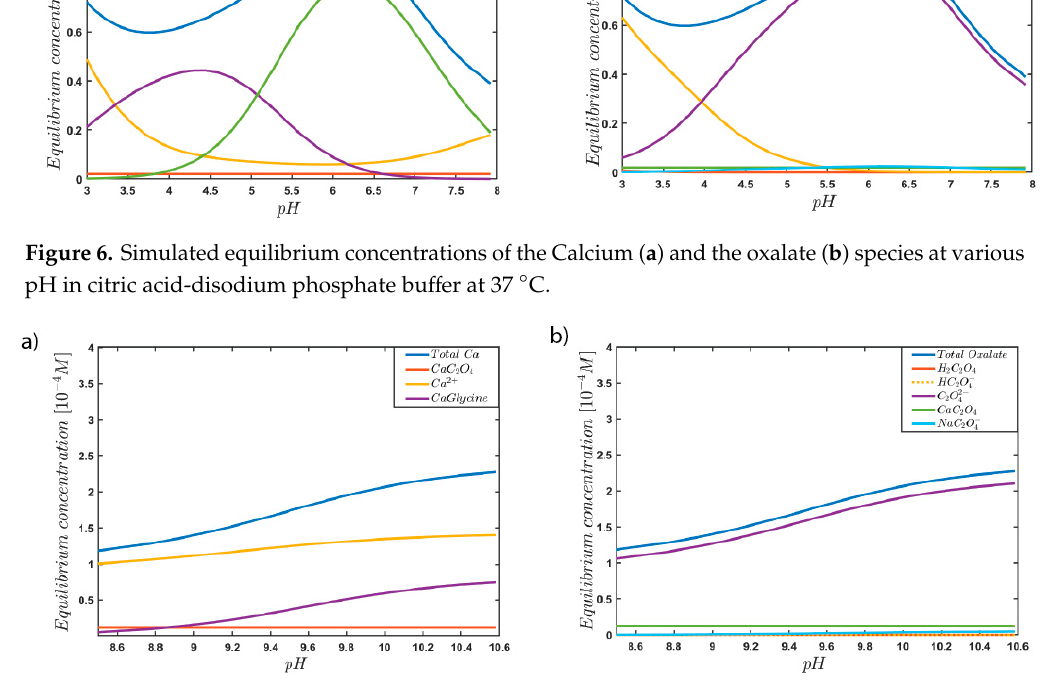
Figure 7. Simulated distribution of the calcium ( a ) and the oxalate ( b ) species at various pH in citric acid-disodium phosphate bu ff er at 37 ◦